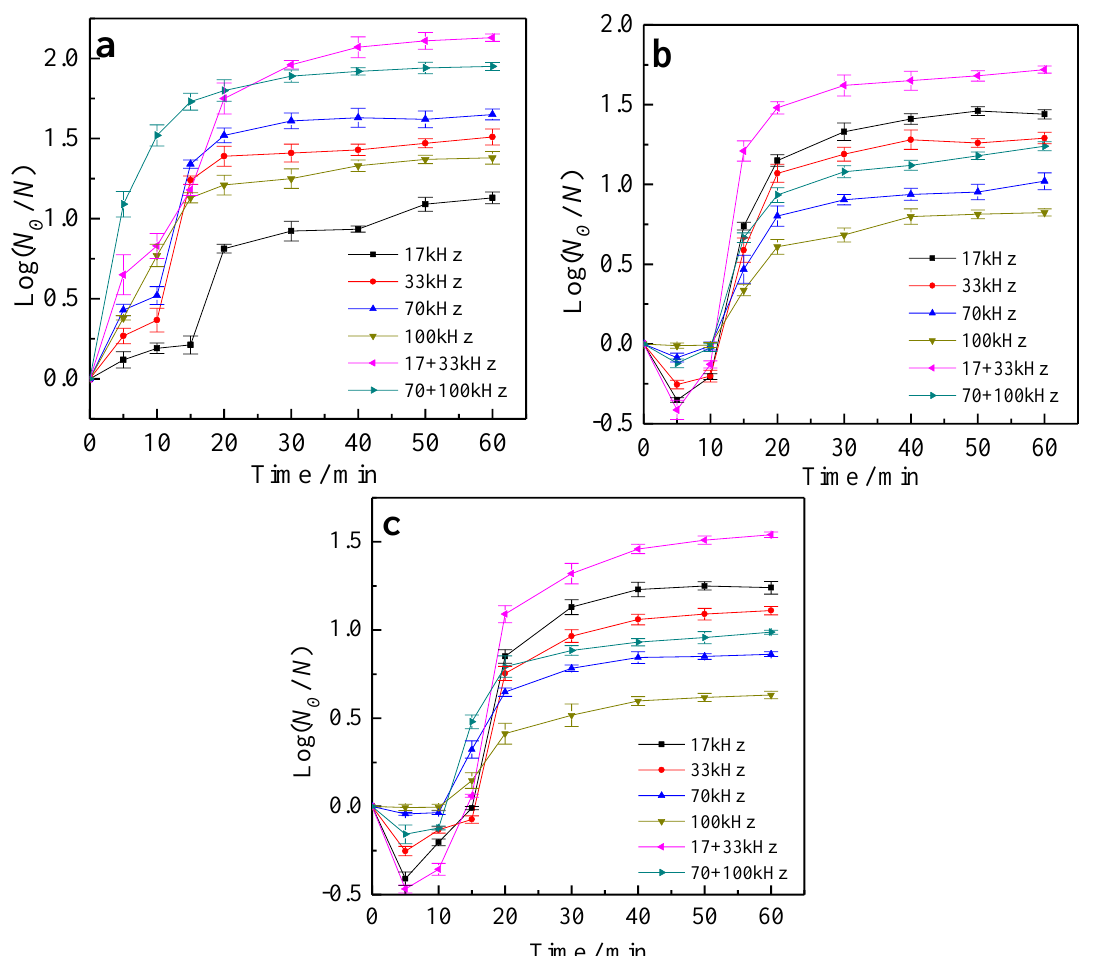
Figure 2. Log inactivation ratio with US treatment alone under different frequencies: ( a ) E. coli , ( b ) S. aureus , and ( c ) B. subtilis . Error bars correspond to standard error of three replicate experiments.